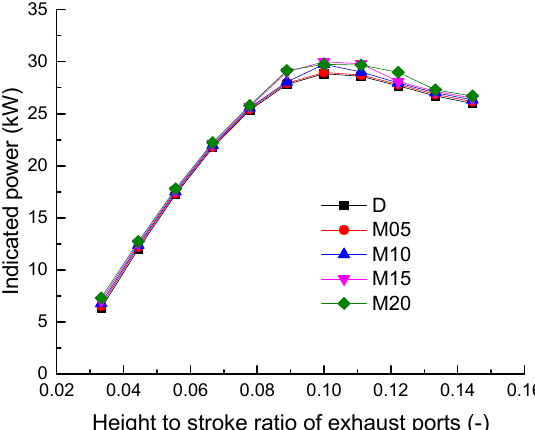
Figure 7. Indicated power under different HSRs of exhaust ports.